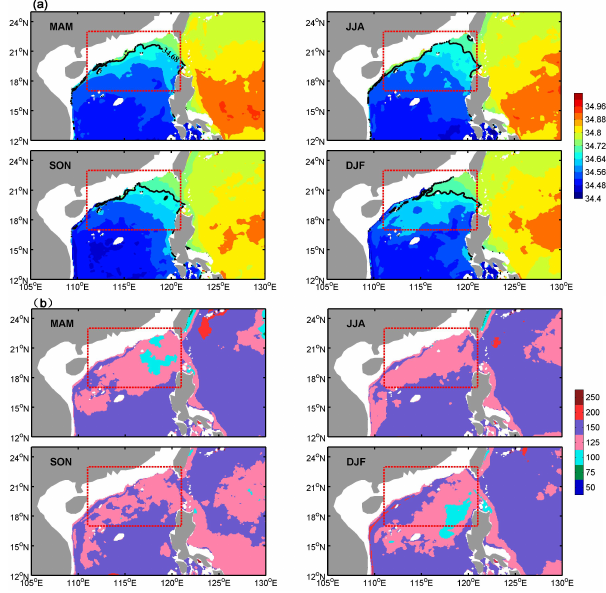
Figure 3. Seasonal variation of (a) the salinity maximum (shaded; PSU) and (b) depth (shaded; m) between 23.5 and 25.5 σθ in the SCS. Black contours represent 34.68 PSU and the red dotted box is our computation